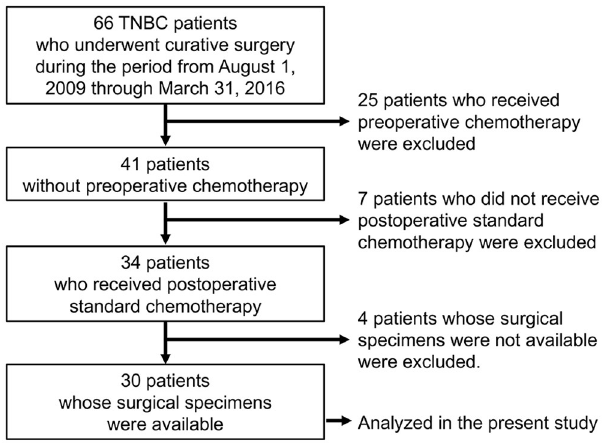
Fig 1. Patient selection flow chart. TNBC patients who did not undergo neoadjuvant chemotherapy but postoperative standard adjuvant therapy from 2009 through 2016 at Juntendo Hospital were investigated in the present study. TNBC; triple-negative breast